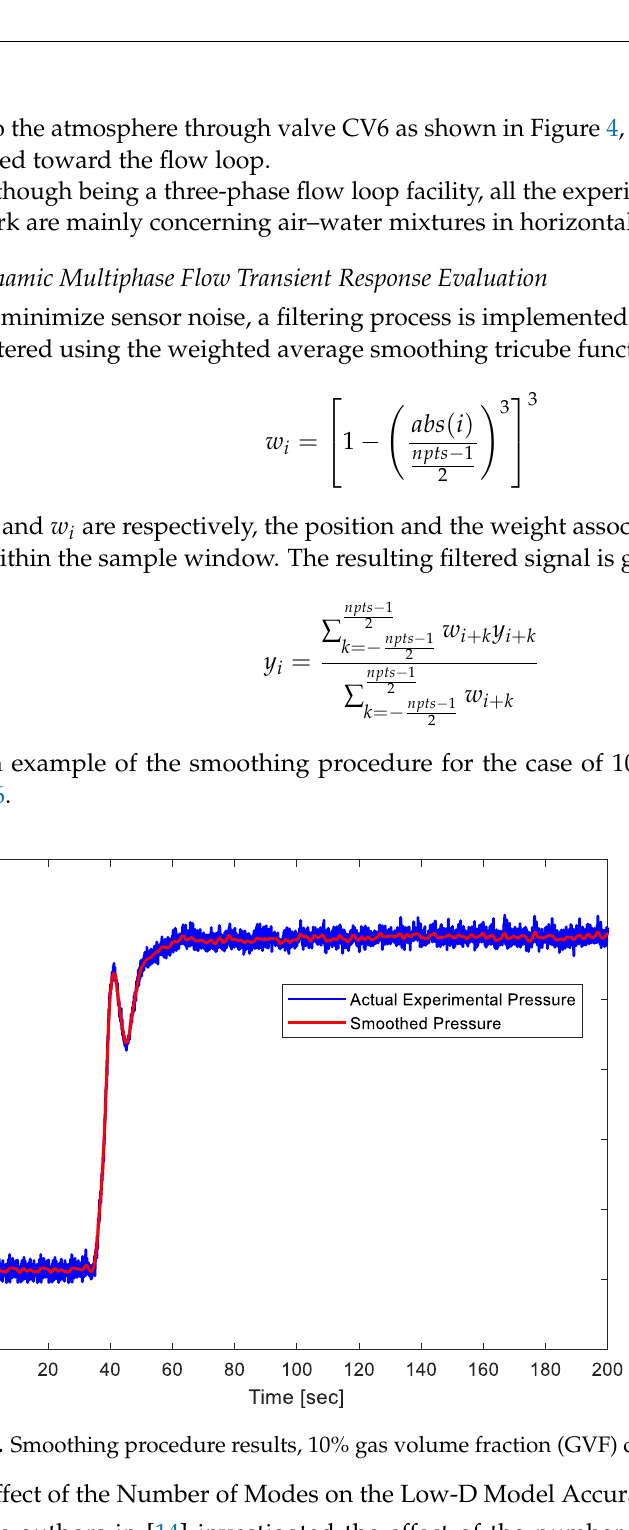
Figure 7. National University of Singapore (NUS) experimental results vs. Low-D model predictions as function of the truncation order n , 10% GVF case. Shown in Figure 8 are the computational time and the mean absolute percent error (MAPE) as a function of the number of modes considered in the Low-D model.